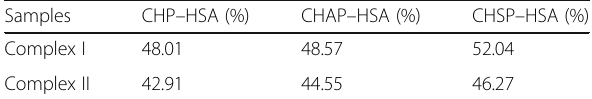
Table 3 The α -helical contents of three samples